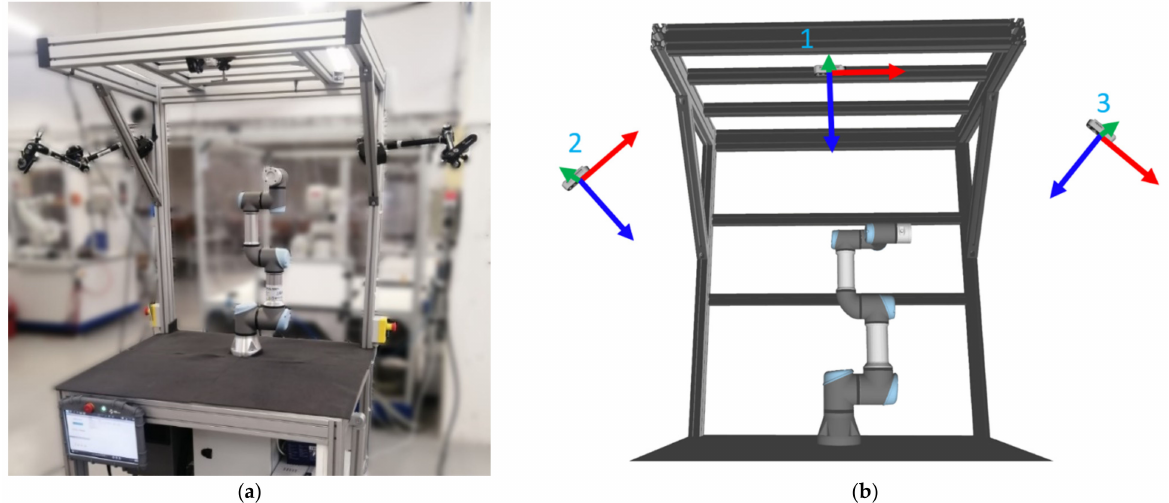
Figure 5. Experimental workspace: ( a ) overview; ( b ) Locations of three RGB-D sensors. View directions ( z -axes) are depicted by the blue